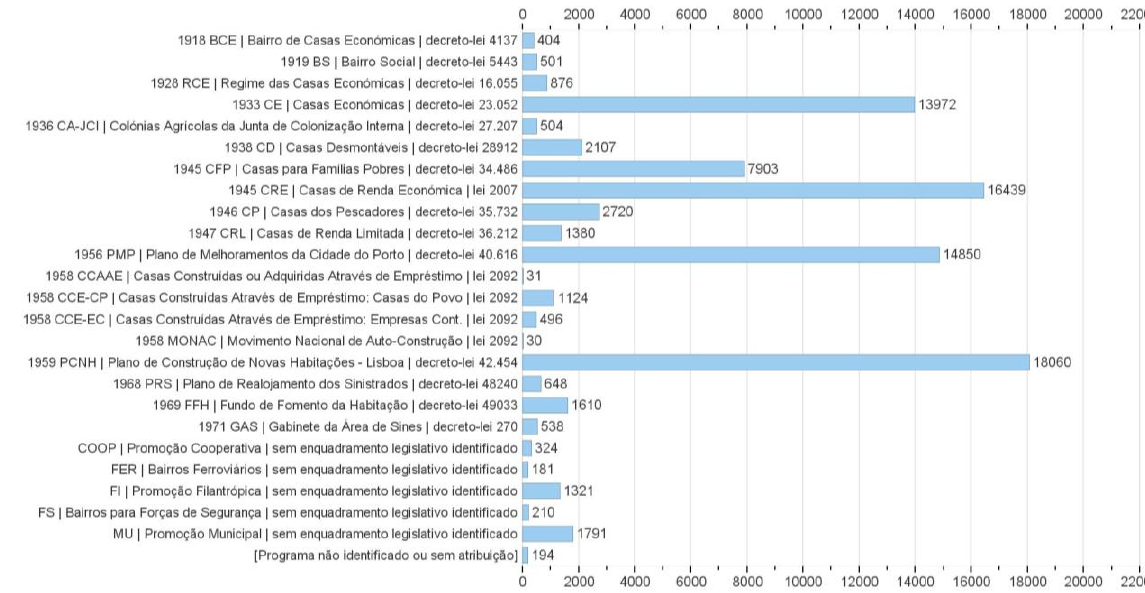
Figure A6. Linear chart. No. of built estates per housing programme. Source: MdH database, 2019. Universe: built estates and phases included in MdH between 1910 and 1974, and number of dwellings. Error factors: in some cases, the number of dwellings is an estimate; the reference date is the first known date; in the case of large urban plans—such as Olivais Norte, Olivais Sul and Chelas—the values entered are the date of the plan and the projected number of dwellings (sep- arate parts of these are not considered in the graphs and are recorded in the database due to their architectural relevance).